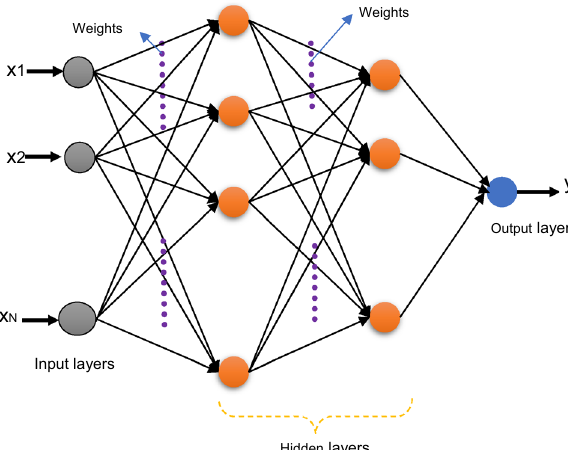
Figure 4. MLP-NN